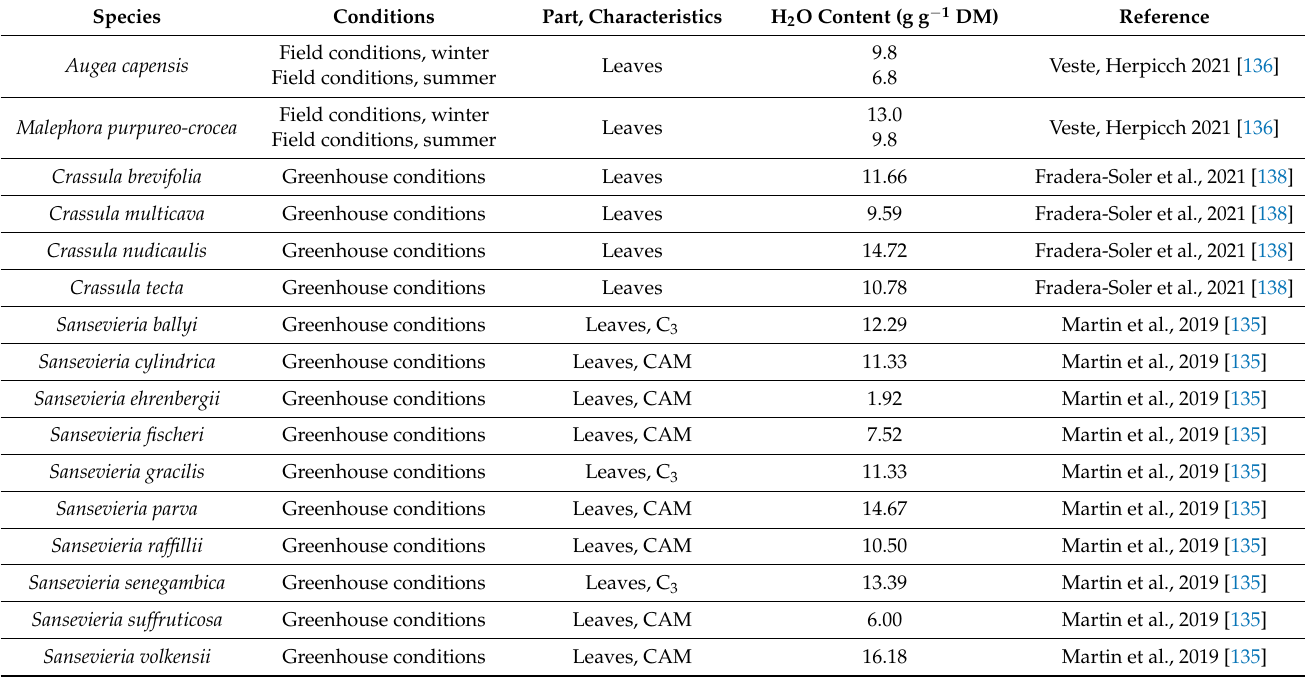
Table 4. Examples of differences in tissue water content values in various succulent plant